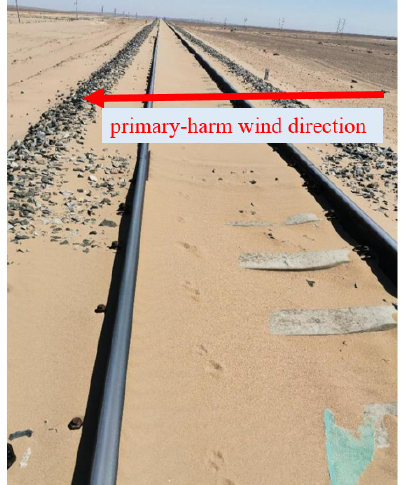
Figure 4. The distribution of sand sedimentation on Harrow